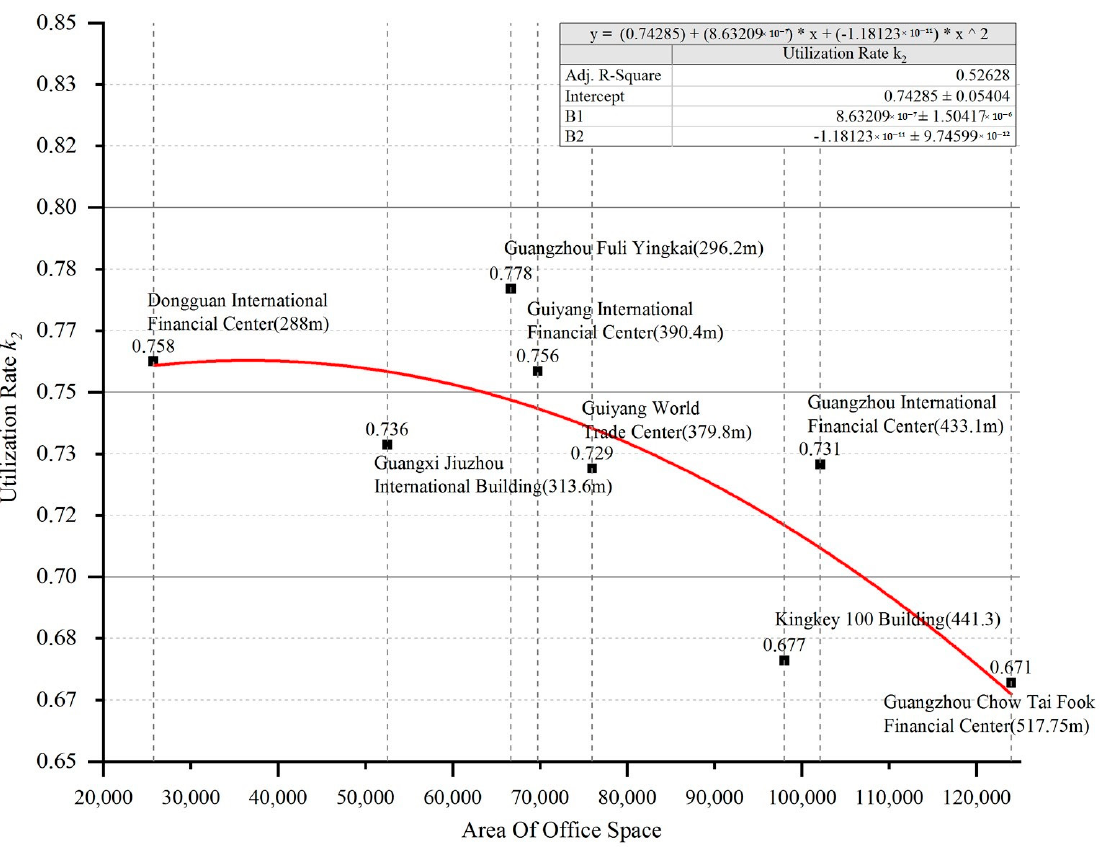
Figure 24. Relationship between the building area of office space and the business utilization rate k 2 . Table 8. Correlation between business indicators and the business utilization rate k 2 .